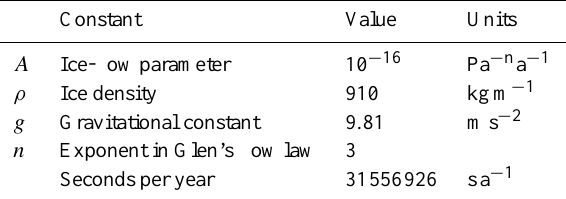
Table 1. Constants for the benchmark experiments. Constant Value Units A Ice-flow parameter 10 − 16 Pa − n a − 1 ρ Ice density 910 kgm − 1 g Gravitational constant 9 . 81 ms − 2 n Exponent in Glen’s flow law 3 Seconds per year 31556926 sa −